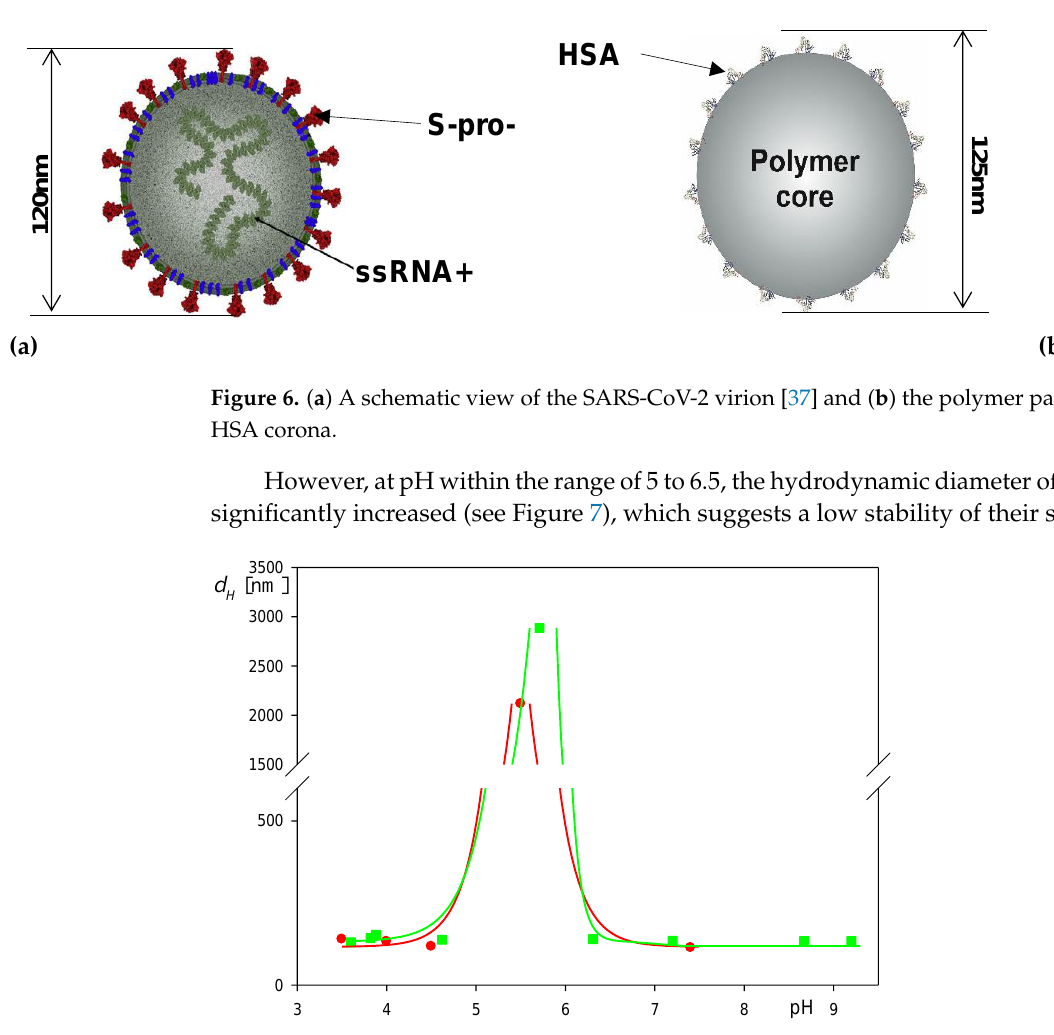
Figure 7. Dependence of the hydrodynamic diameter of the particles with the HSA corona on pH: corona coverage 0.80 mg m -2 , ( ● ) 10 mM NaCl, ( ■ ) 1 mM NaCl. The lines represent guides to the eyes.